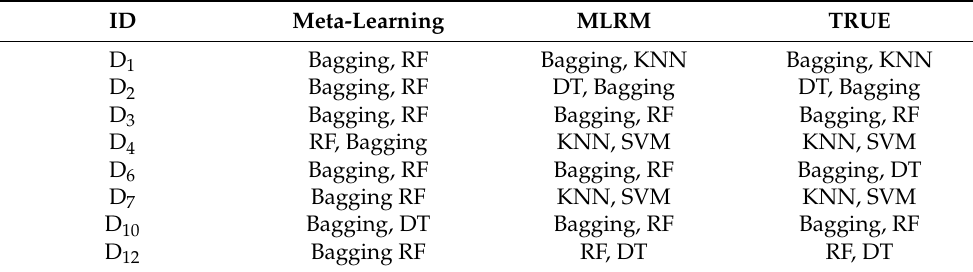
Table 9. Recommendation results between MLRM and meta-learning in senaries.